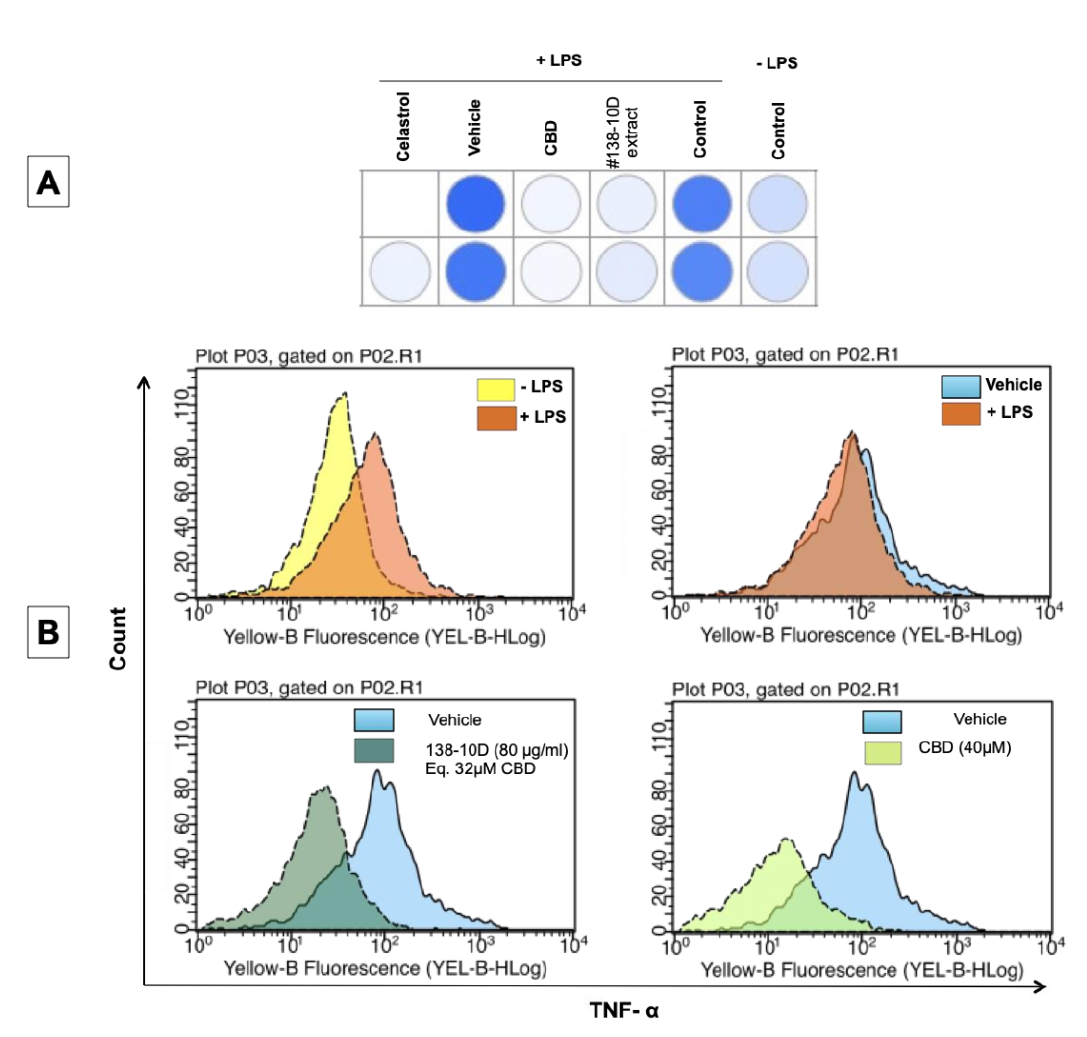
Figure 4. Anti-inflammatory activity assay. THP-1 monocyte cells were treated as indicated for 1 h, then were stimulated with LPS for 2.5 h followed by incubation with a TNF- α detection antibody (TNF- α secretion assay). The expression of membrane bound TNF- α was detected by flow cytometry. ( A ) Analysis shows the level of TNF- α release in the presence or absence of the LPS stimulator and treatments (dark blue = high level release, gray color = inhibition level of TNF- α ). ( B ) Representative histograms of fluorescence intensity versus cell